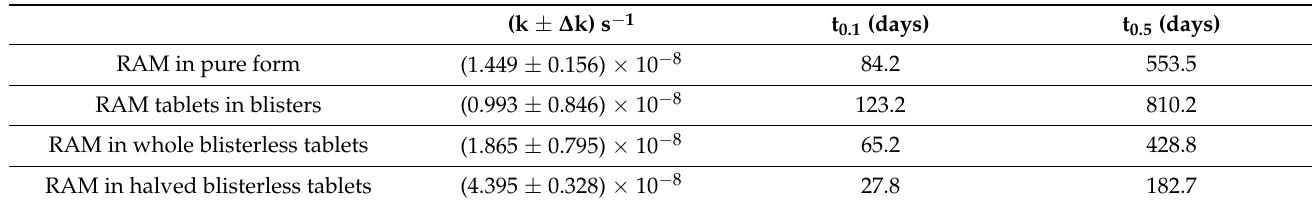
Table 5. Kinetic parameters of solid-state RAM decomposition in final drug formulation.